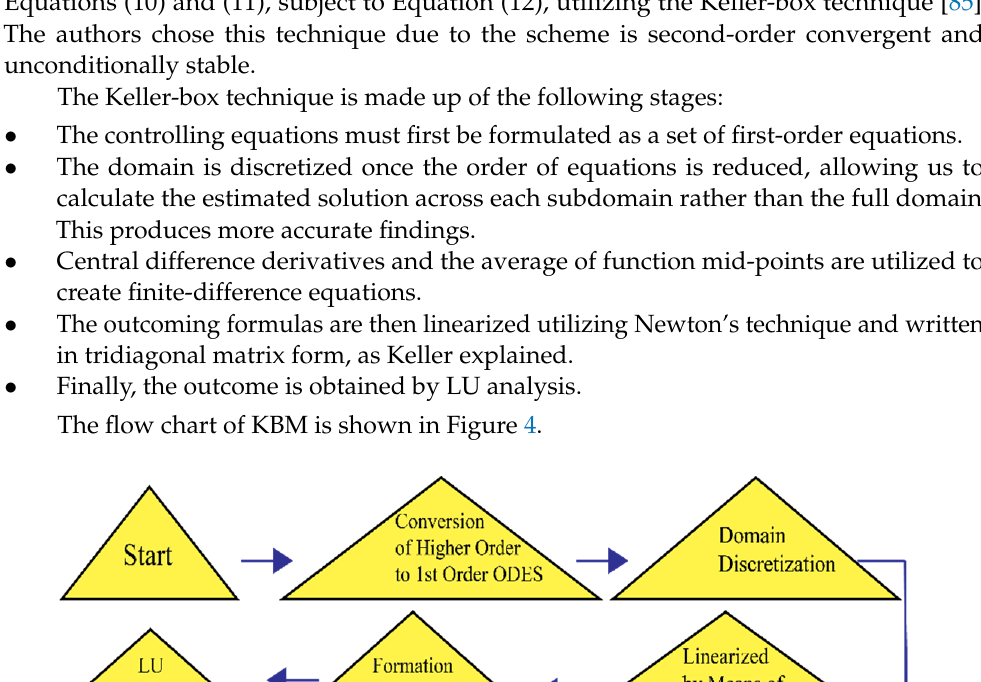
Table 3. Comparing − θ (cid:48) ( 0 ) with alteration in Prandtl number, and taking φ = 0, ϑ M = 0, Λ M =